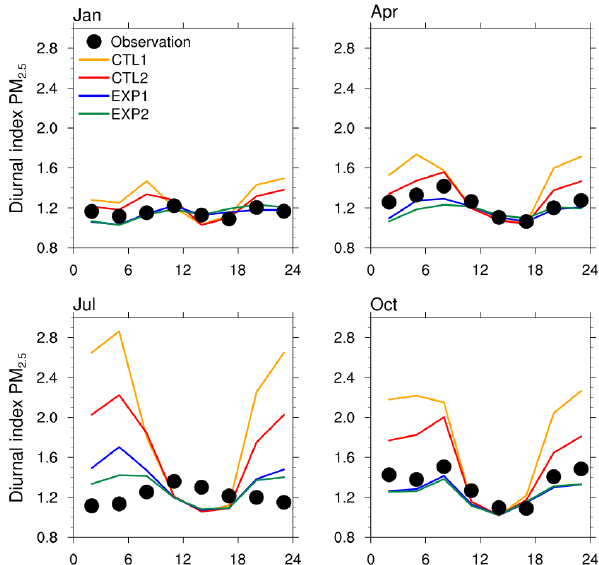
Figure 10. Diurnal index of surface PM 2 . 5 concentrations within 24h averaged over the YRD region of East China (within the black box of Fig. 1a) for January, April, July, and October of 2018 from experiments CTL1, CTL2, EXP1, and EXP2, and observations. Both the simulated results and observations are sampled at the model output frequency, i.e.,